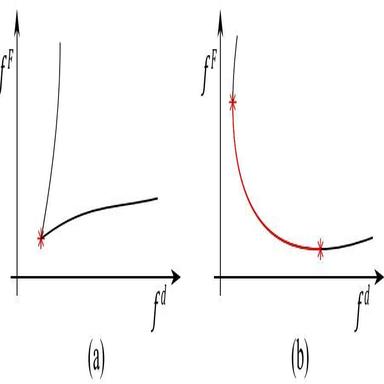
Multi-objective solutions with (a) non-conflicting behavior and (b) conflicting behavior.